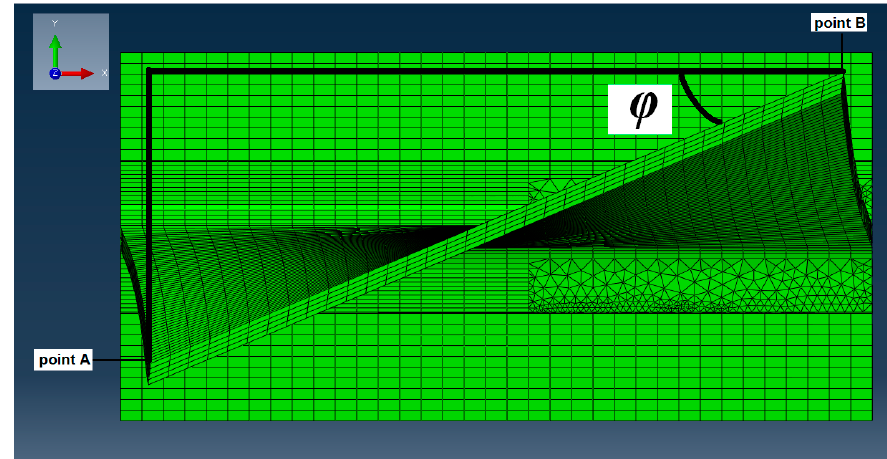
Figure 29. Definition of angle of twist. Its reduction when a centrifugal load is applied is called “untwist”.